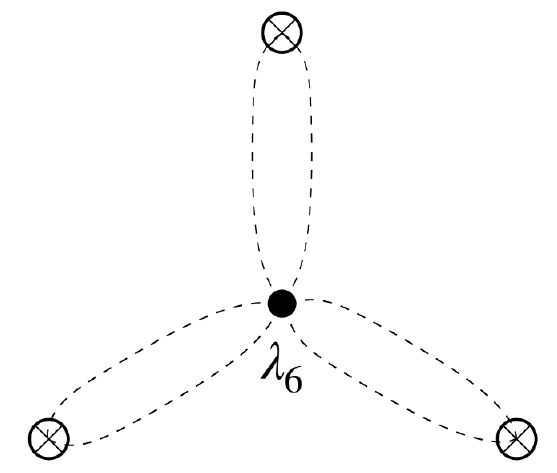
Figure 3 . The contribution of the sextic coupling (cid:21) 6 to the three-point function of J b . There are im- plicit blobs connecting adjacent scalar propagators, which sum up the gauge interactions at large N